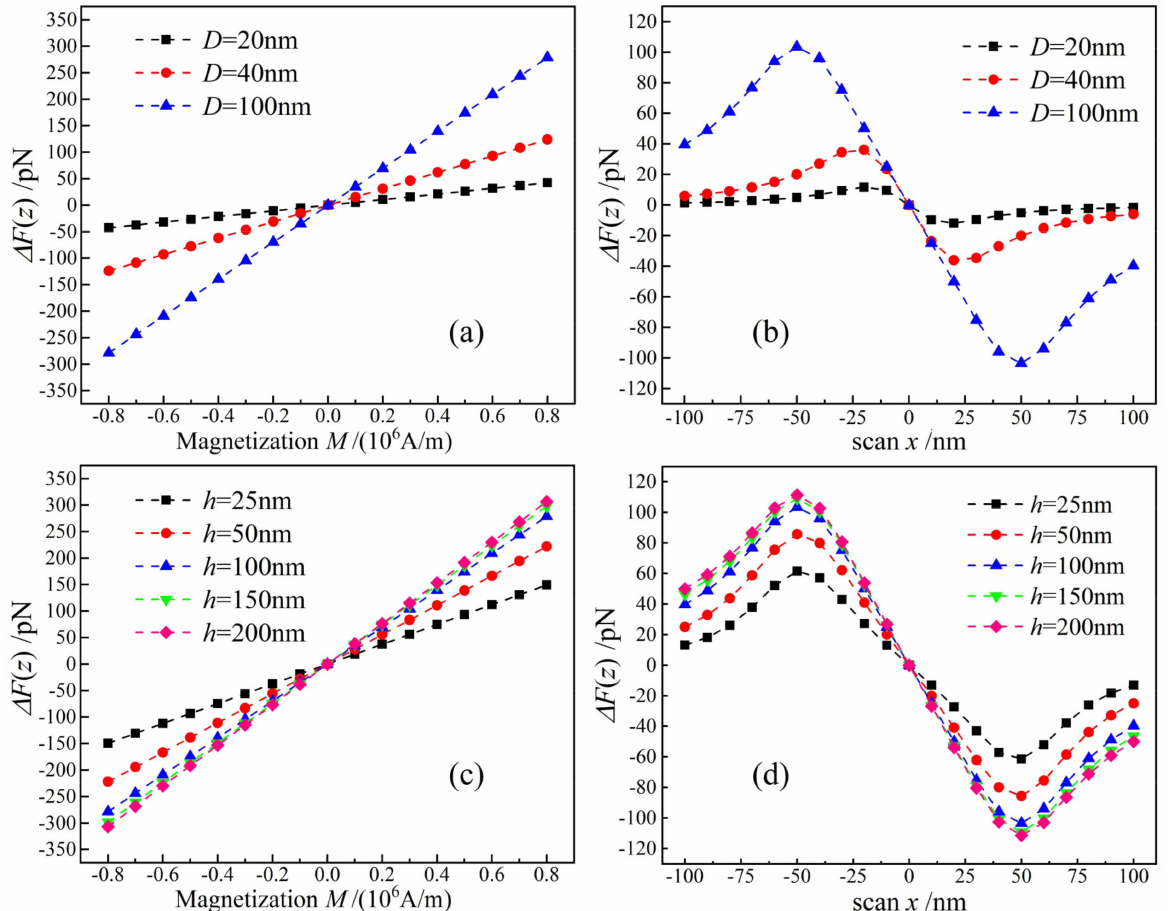
Figure 4. Magnetic forces versus magnetization of ferromagnetic single-domains with different sizes and magnetic moment orientations. ( a ) h = 100 nm, magnetic moment orientation +z; ( b ) h = 100 nm, magnetic moment orientation − x; ( c ) D = 100 nm, magnetic moment orientation +z; and ( d ) D = 100 nm, magnetic moment orientation −